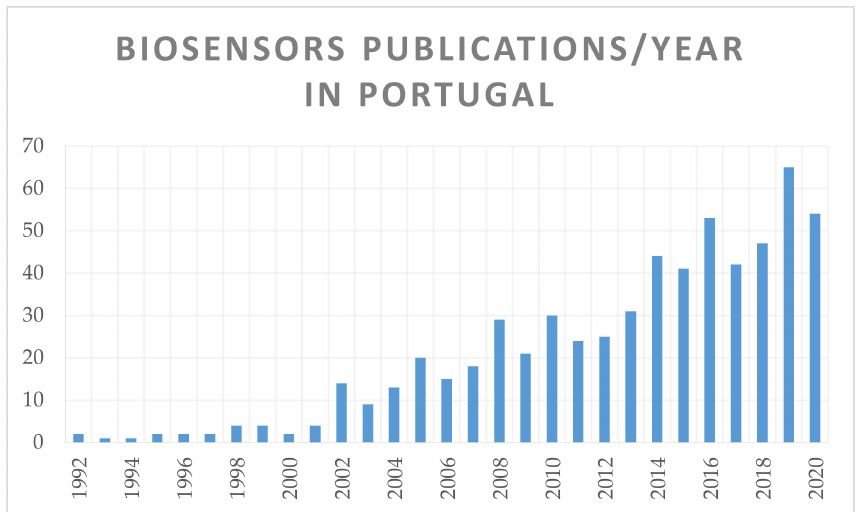
Figure 1. Data obtained from webofknowledge.com from 630 records cross-searching keywords: ALL FIELDS: (biosensor) and ADDRESS: (Portugal) in Web of Science